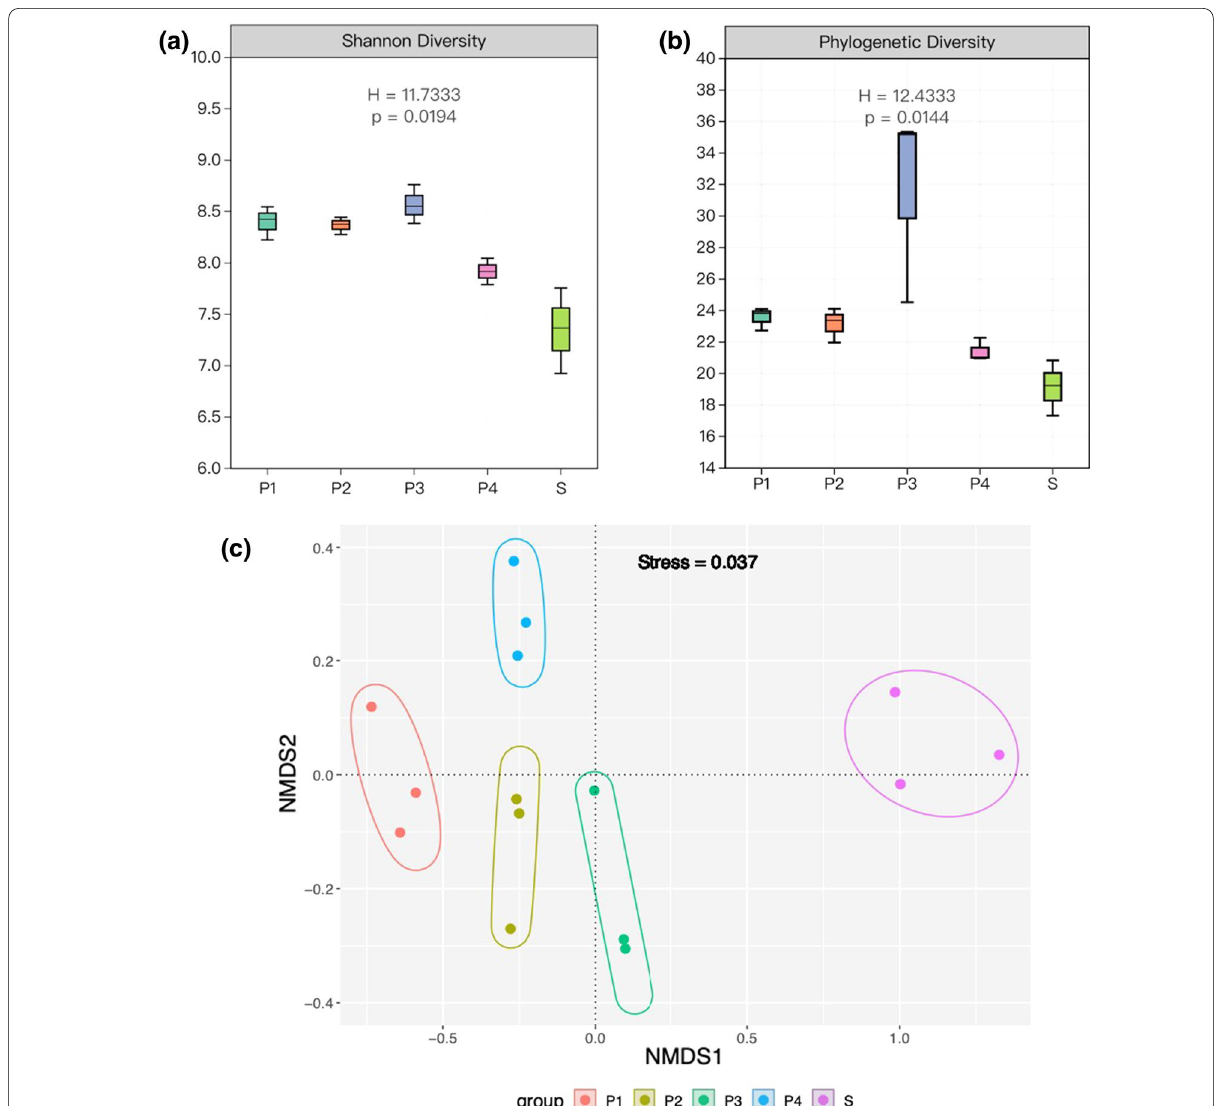
Fig. 1 Significant differences ( P < 0.05) were detected between alpha-bacterial communities (Shannon index) of surrounding seawater samples and shrimp ponds ( a , b ). Data was also clustered to Non-metric multidimensional scaling (NMDS) plot for beta-diversity ( c